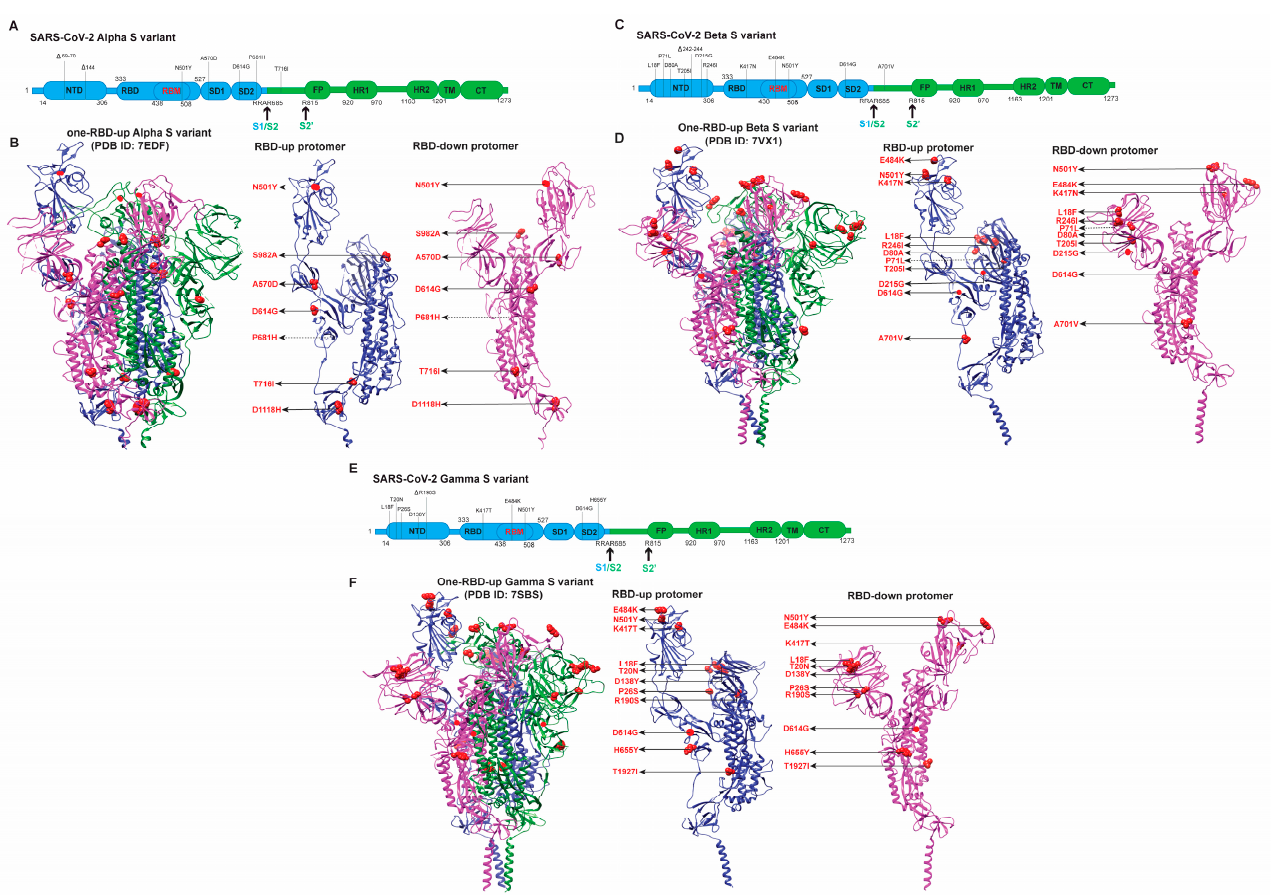
Figure 3. Accumulated mutations in the S early VOCs. ( A , B ) Amino acid substitutions are shown in the S domain organization ( A ) and depicted in the one-RBD-up structure ( B ) of the S Alpha variant (PDB ID 7EDF). Amino acid substitutions are highlighted in two different RBD-oriented protomers (RBD-up and RBD-down). The dotted lines indicate the mutated amino acid residues which are not resolved in the structure. ( C , D ) Illustrations as in ( A ) and ( B ), respectively, for the S Beta variant (PDB ID 7VX1). ( E , F ) Illustrations as in ( A / C ) and ( B / D ), respectively, for the S Gamma variant (PDB ID